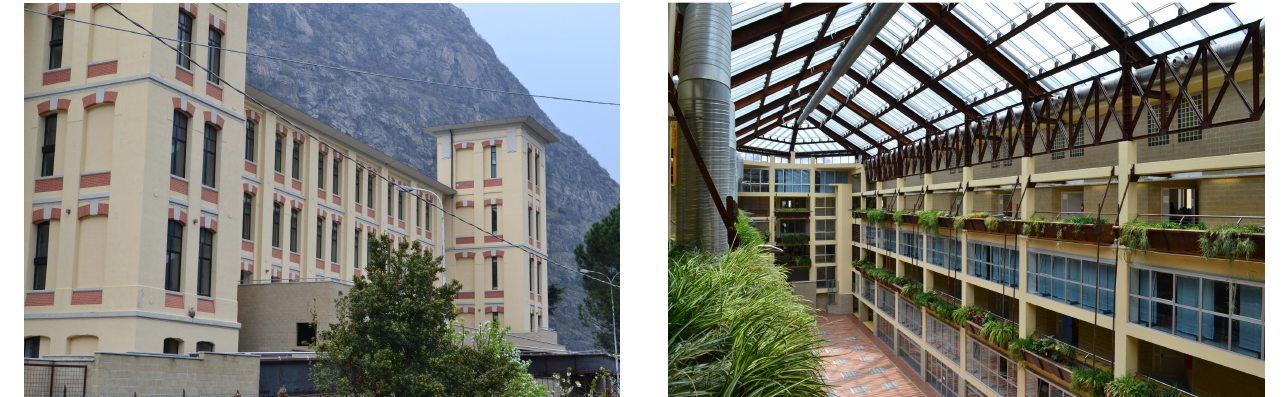
Figure 8. Monitored building in Verrès (Aosta), Italy.